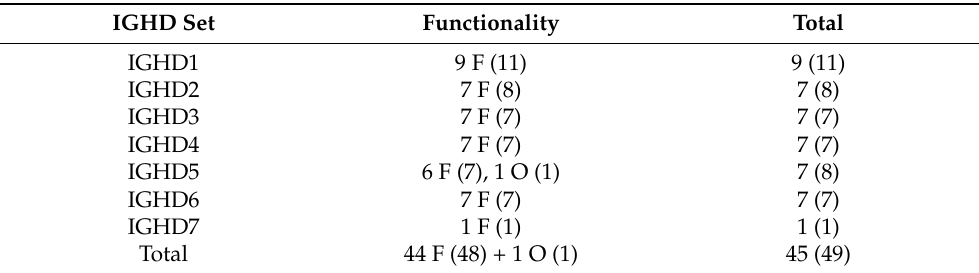
Table 4. For each IGHD set, number of IGHD genes per functionality and, between parentheses, number of